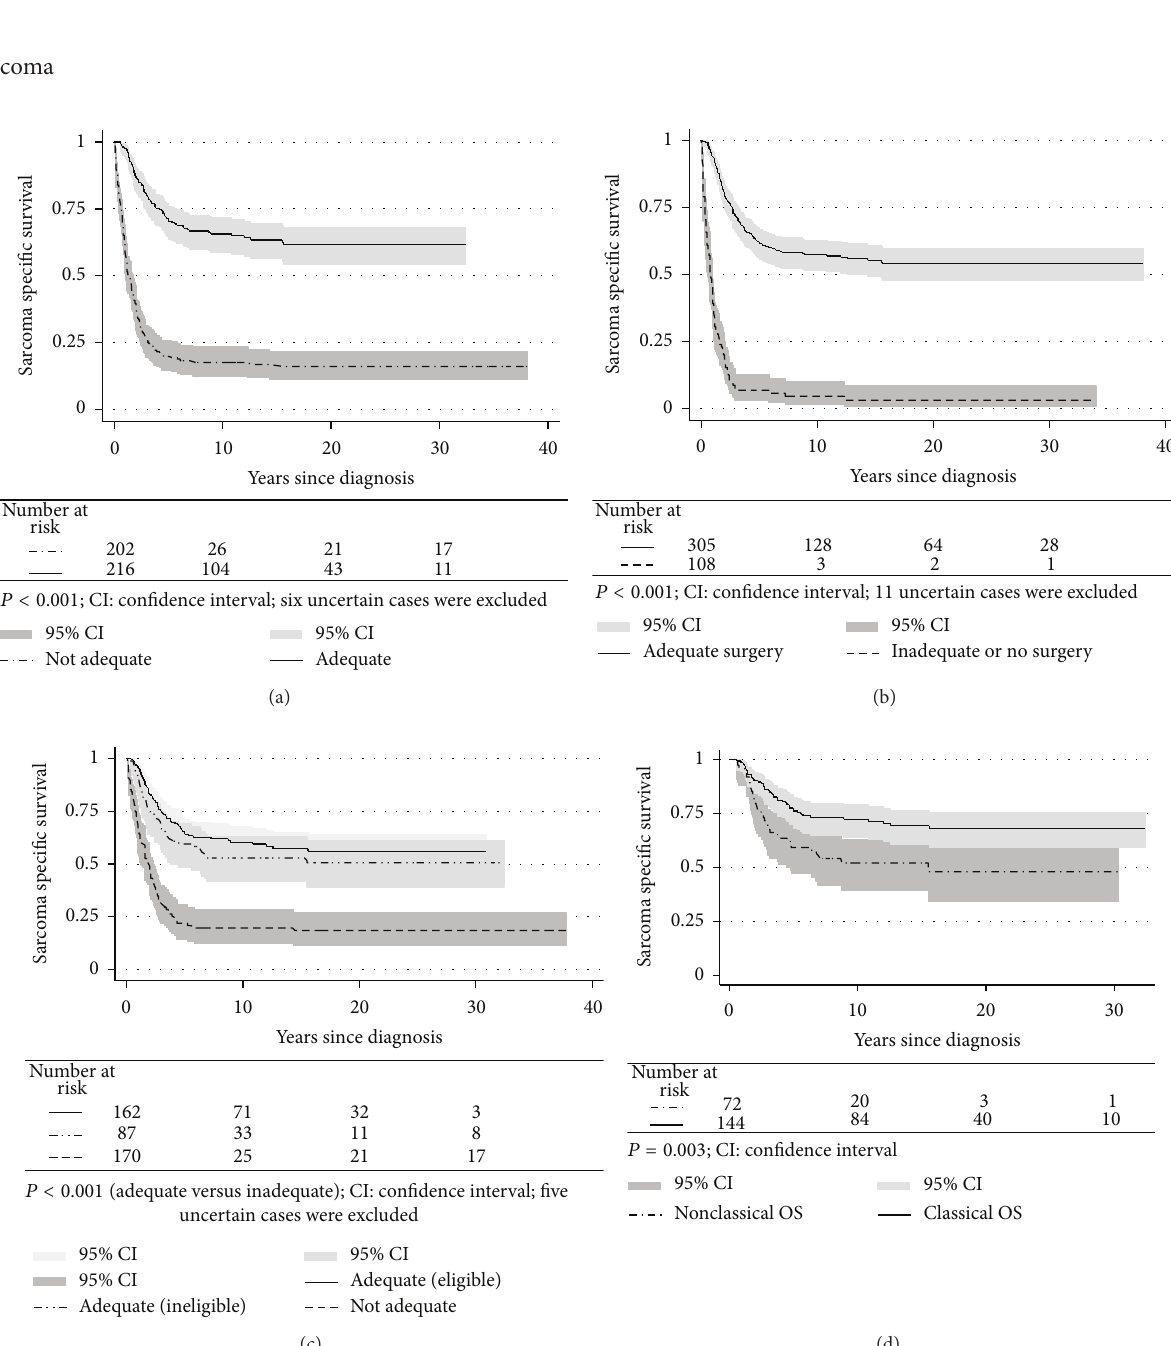
Figure 4: Sarcoma specific survival for osteosarcoma (OS) patients dependent on adequate primary treatment (both surgery